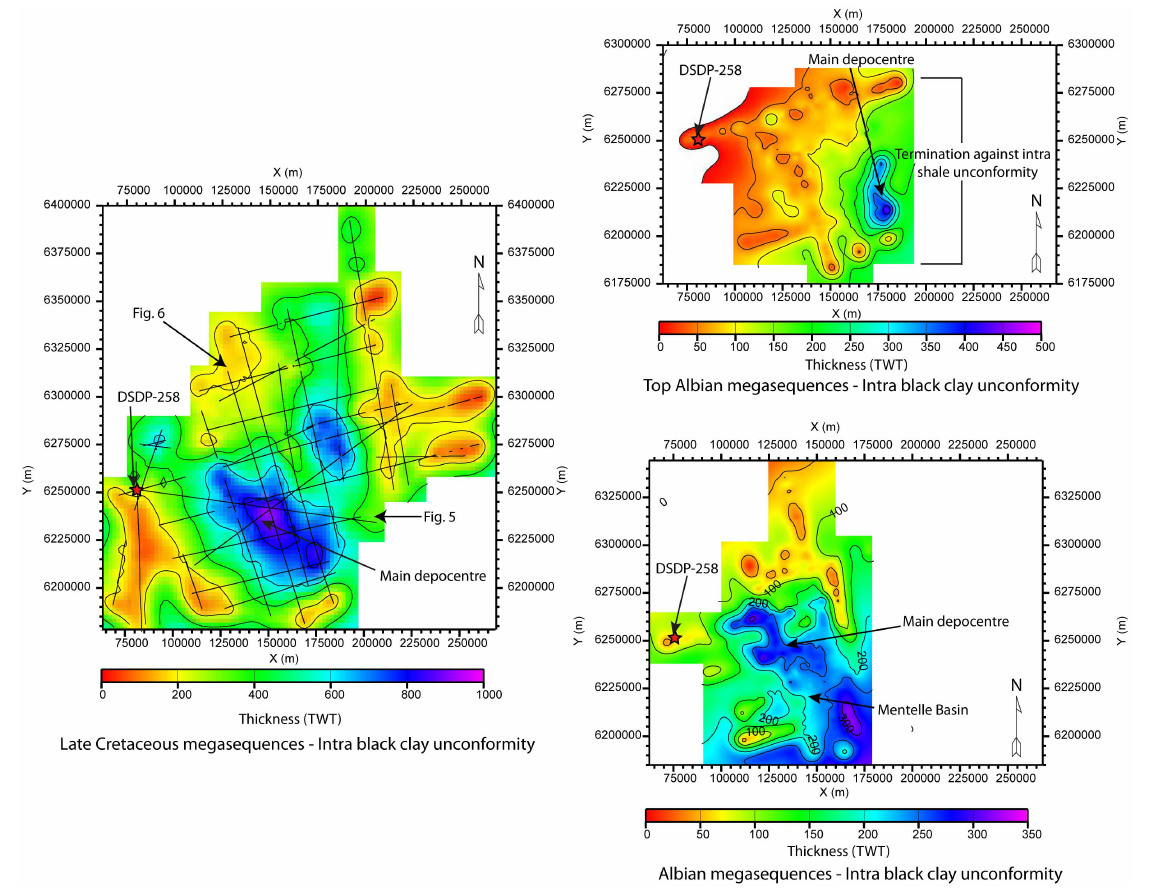
Fig. 9. Isochron maps for the Cretaceous black clay megasequences. Representative thickness changes highlighted within each isochron are interpreted to reflect changes in thermal contraction (flexure), subsidence and accommodation